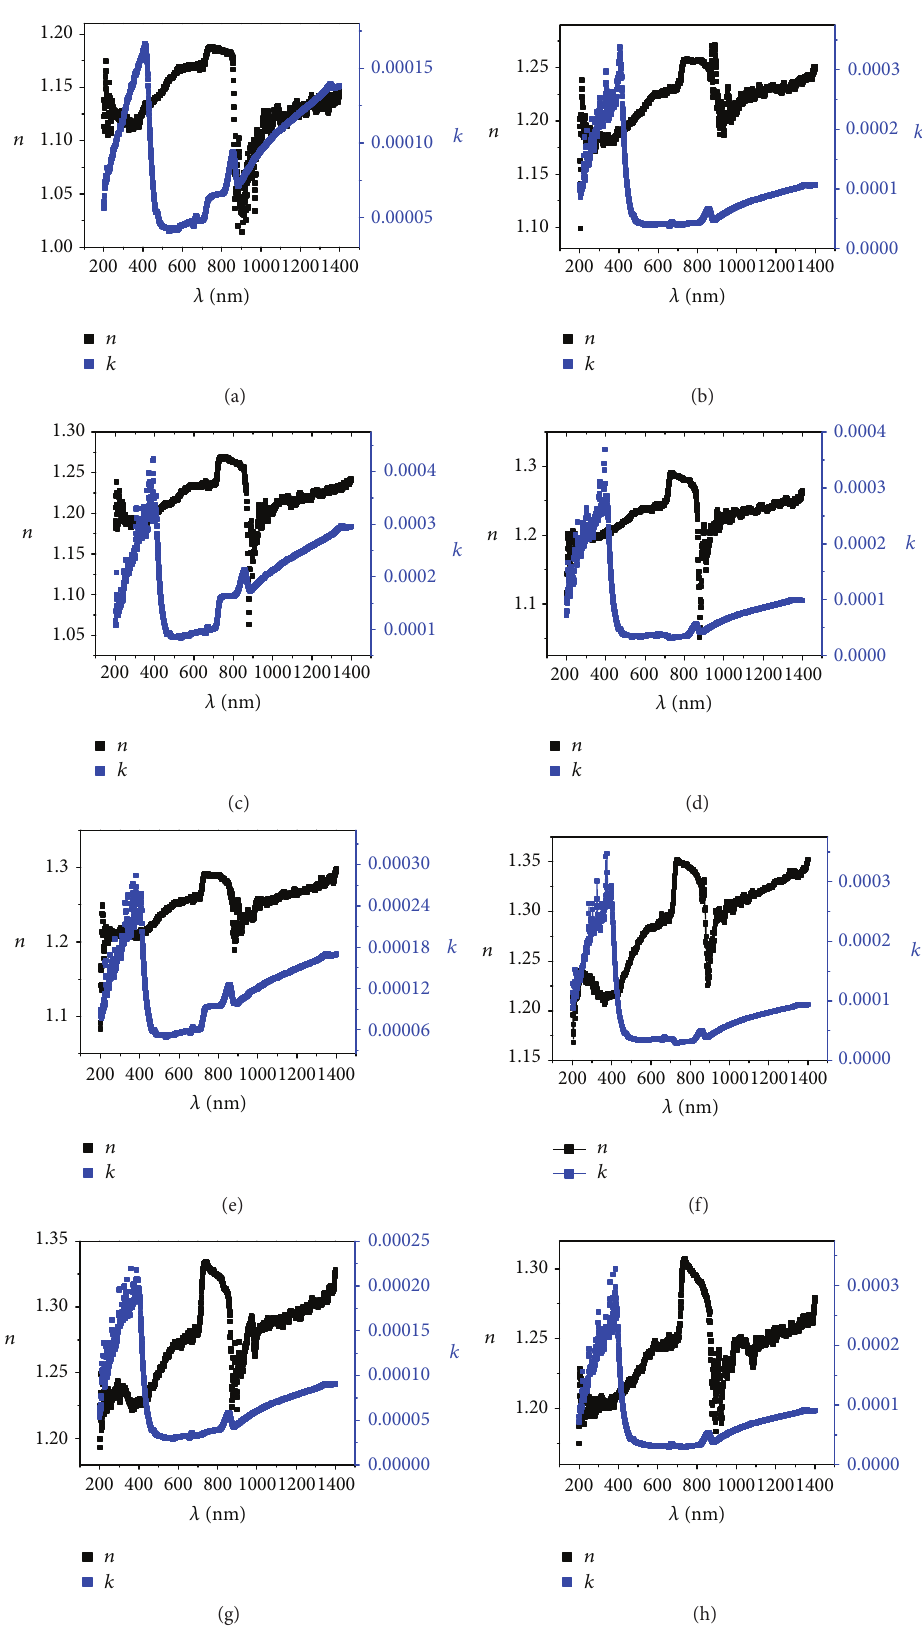
Figure 5: Variation of real ( 𝑛 ) and imaginary ( 𝑘 ) parts of refractive index with wavelength of 40SiO 2 ⋅ 𝑥 ZnO ⋅ ( 60 − 𝑥 )Bi 2 O 3 glass system for 𝑥 = 0 , 5, 10, 15, 20, 25, 30, and 35 in (a), (b), (c), (d), (e), (f), (g), and (h),